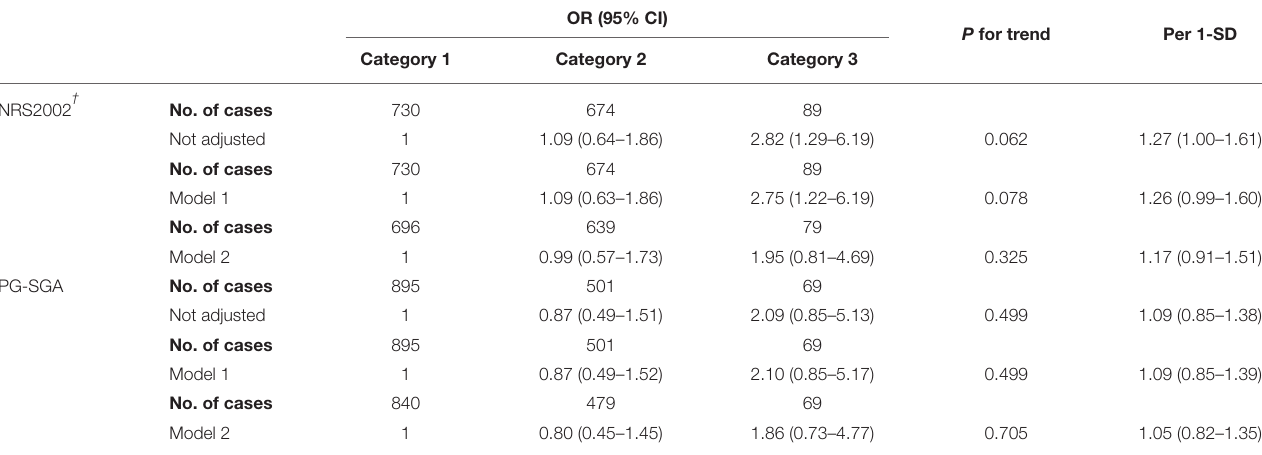
TABLE 3A | The association of NRS2002 and PG-SGA with post-operative infections (GC).